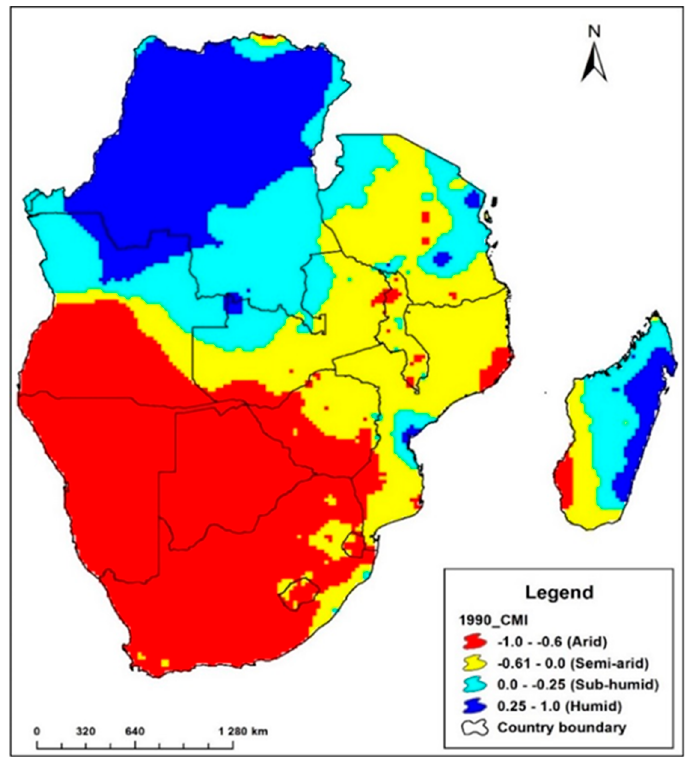
Figure 4. Water scarcity and aridity levels and distribution in the Southern Africa Development Community (SADC) region. Source: Developed by